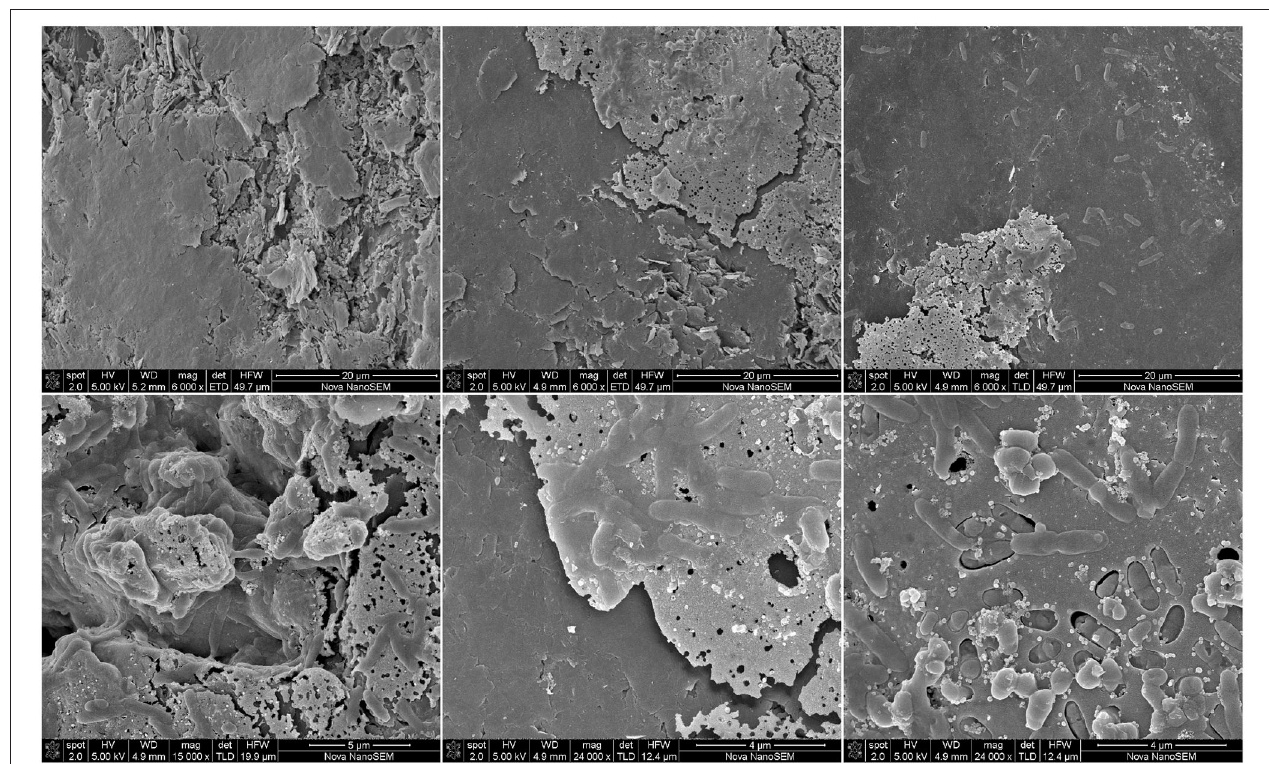
FIGURE 6 | Scanning electron microscopy of MEC-a working electrode (WE) after being removed from the cell and cultured in acetate:fumarate in anaerobiosis during 21 days. Different areas of the graphite are shown at low (Top) and high magnification (Bottom) . No cables of bacteria were found, and the cells were mostly dispersed over the surface. Imprints of removed cells can also be distinguished.